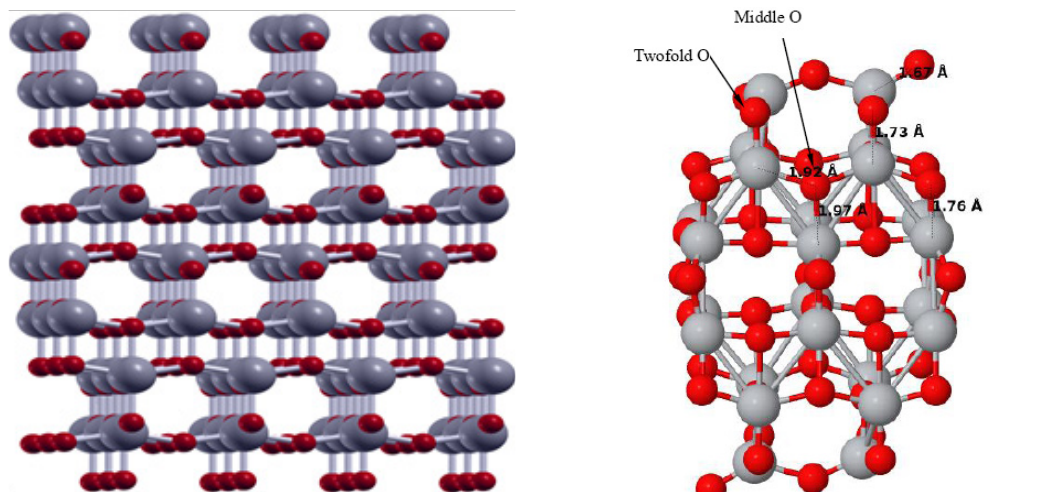
Fig. 2. Optimized geometry of the pristine TiO nanoparticle with bond length